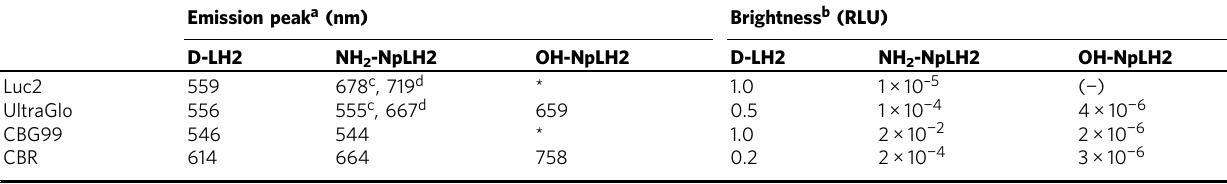
Table 1 Substrate